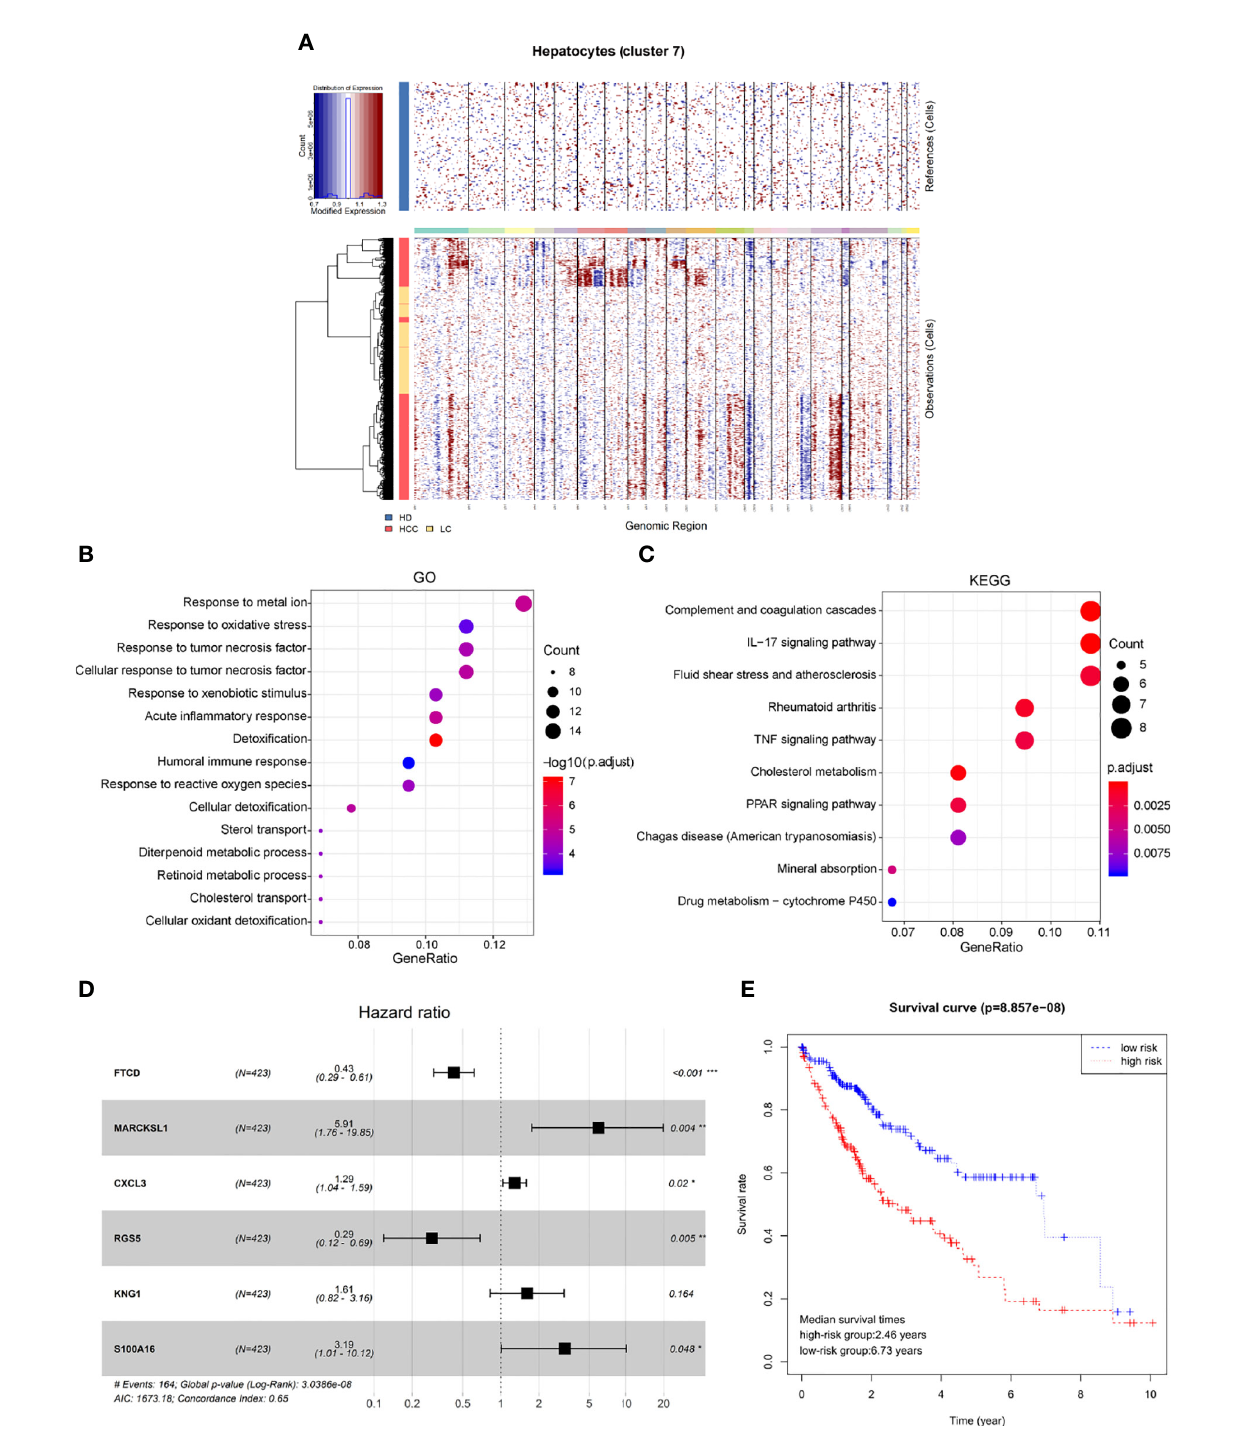
FIGURE 4 | Identi fi cation of HCC prognosis associated genes from malignant hepatocyte single cell cluster. (A) Copy number variation in hepatocyte group, the healthy group (healthy donor, HD) was used as a reference, the cirrhosis group (Liver cirrhotic patient, LC), and the HCC group (HCC patient) were used as observation groups, red represents overexpression of genes and blue represents low expression. (B) The result of GO functional enrichment analysis, p.adjust < 0.01. (C) The result of KEGG pathways enrichment analysis, p.adjust < 0.01. (D) Hazard ratio of the six genes. (E) Kaplan-Meier estimates of overall survival from HCC patients in TCGA based on six-gene signatures, patients were divided into low-risk group and high-risk group according to median risk